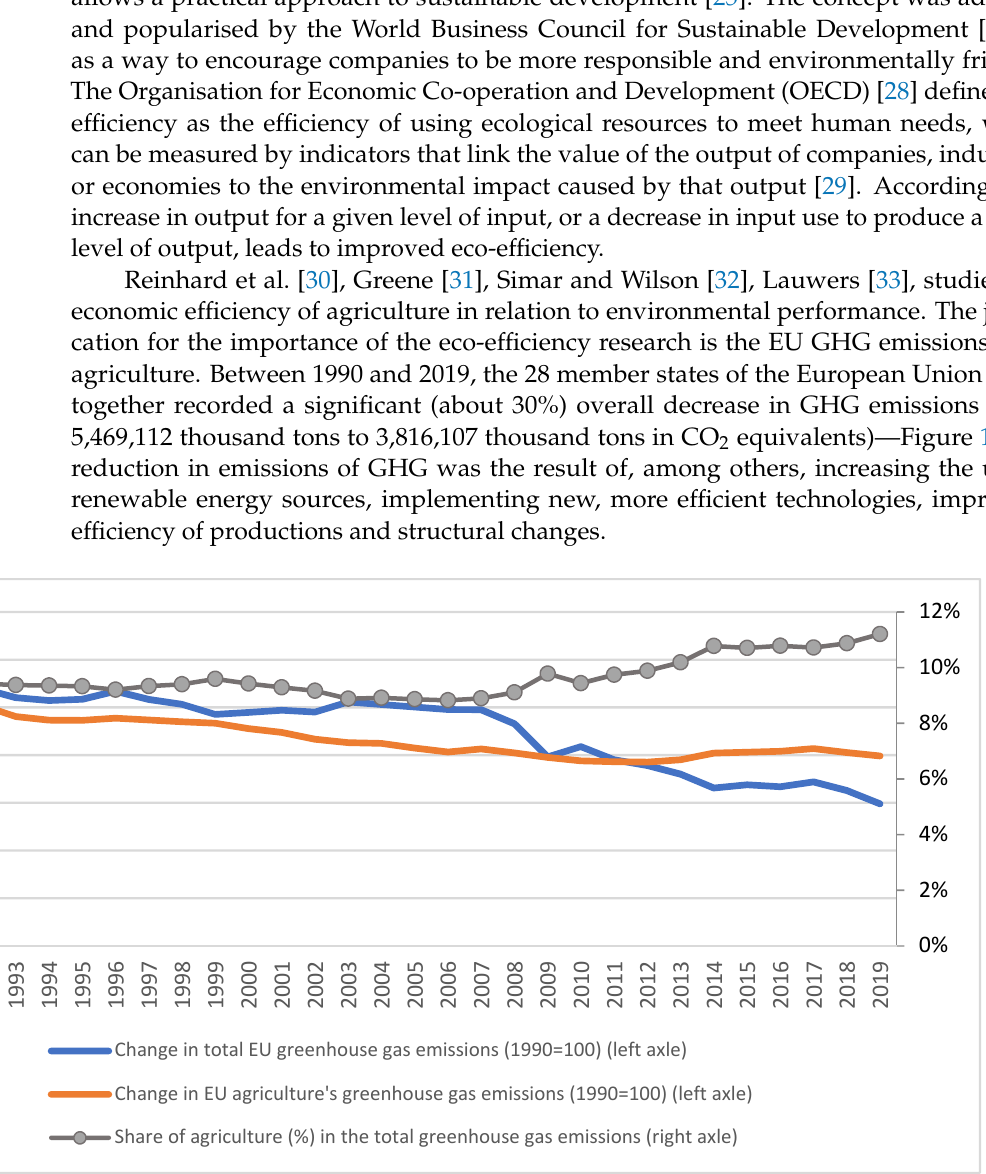
Figure 2. Sources of greenhouse gas emissions in the EU-28, 2019. Source: European Environment Agency and Eurostat. Table 1. Share of GHG from agriculture* of a given country in the total GHG from EU agriculture and in the total GHG in a given country, 2019 (%). Country